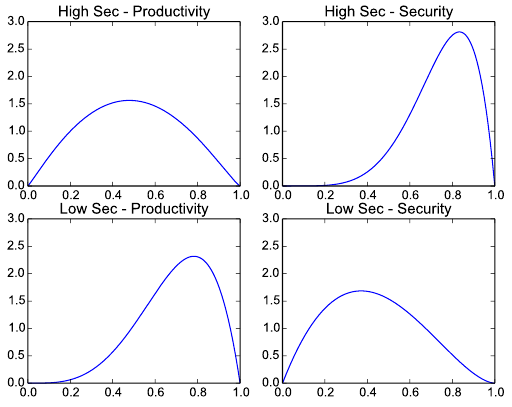
Figure 11: PDFs of employee preference distributions